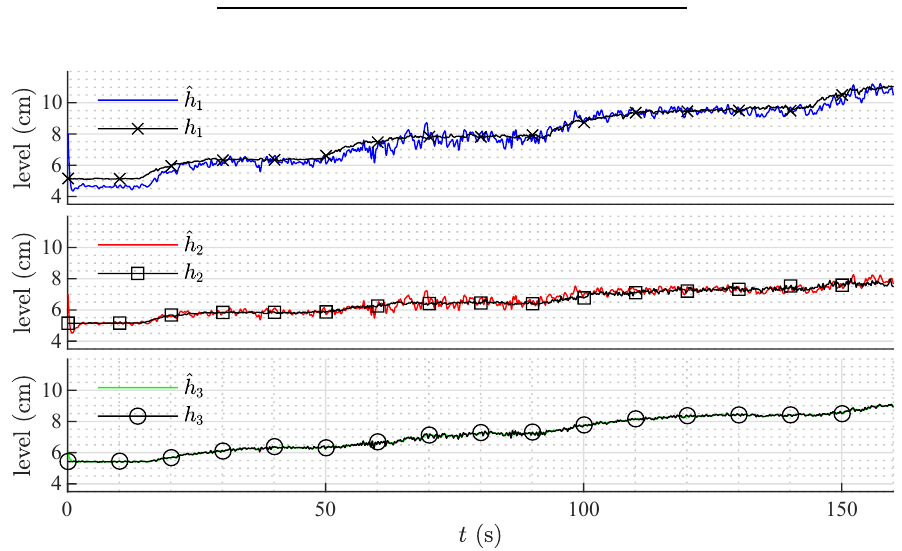
Figure 13. Luenberger observer performance: 30% variation in all constant parameters.